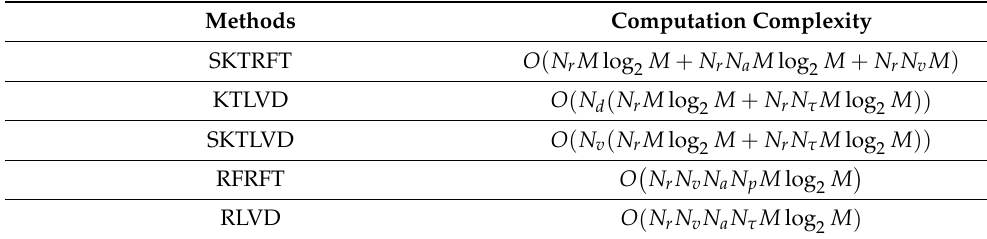
Table 2. Comparison of computational complexities.